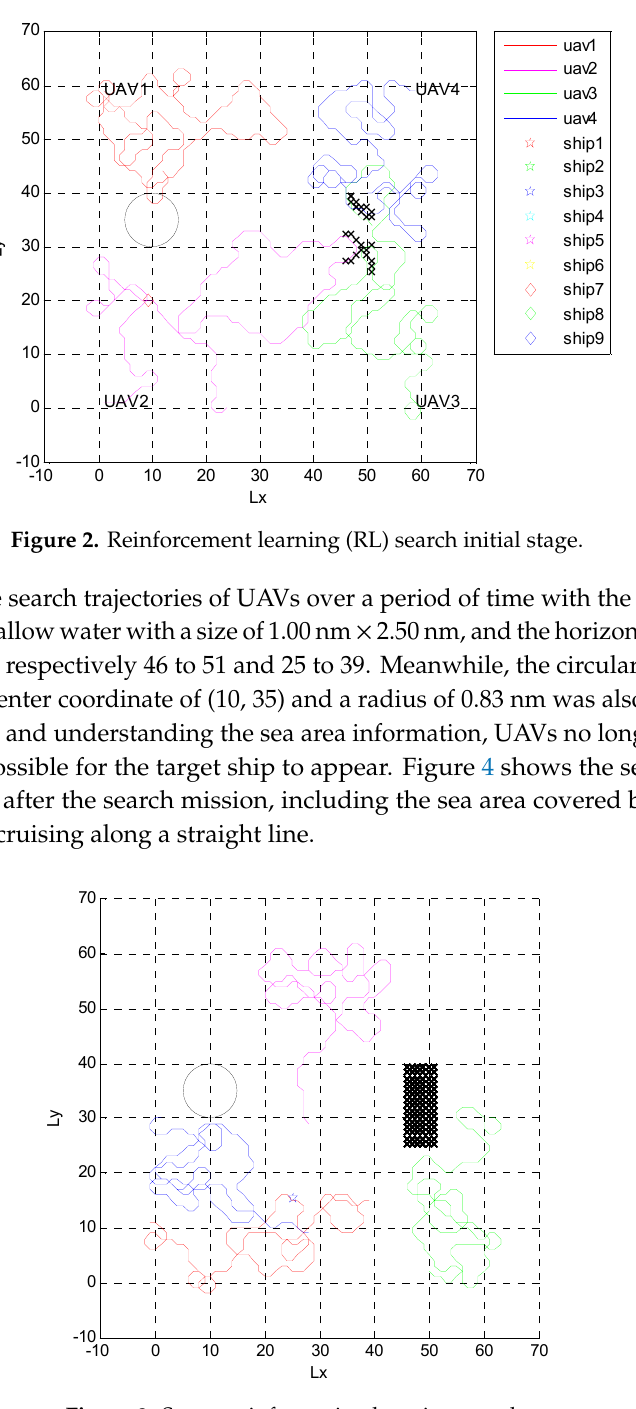
Figure 4. Unmanned aerial vehicle (UAV) search result under proposed method.